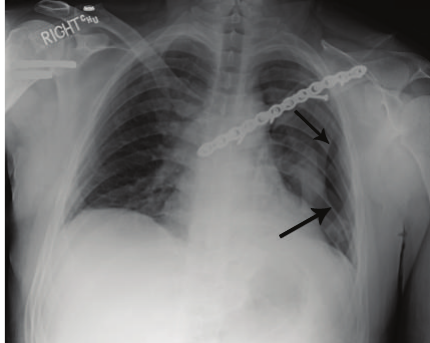
Figure 4: Chest radiograph taken in the recovery room after surgery. The arrows indicate the pneumothorax.